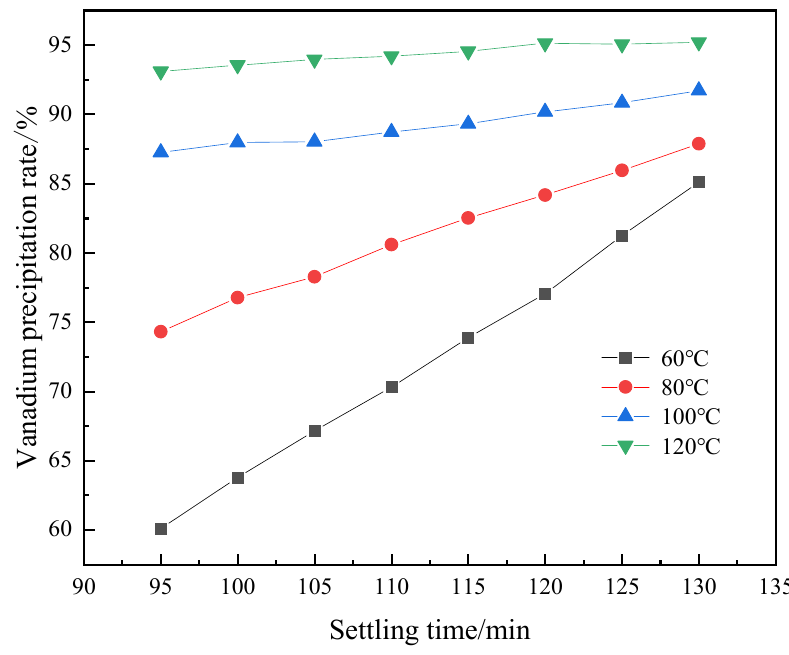
Figure 6. Vanadium precipitation rate at different temperatures.